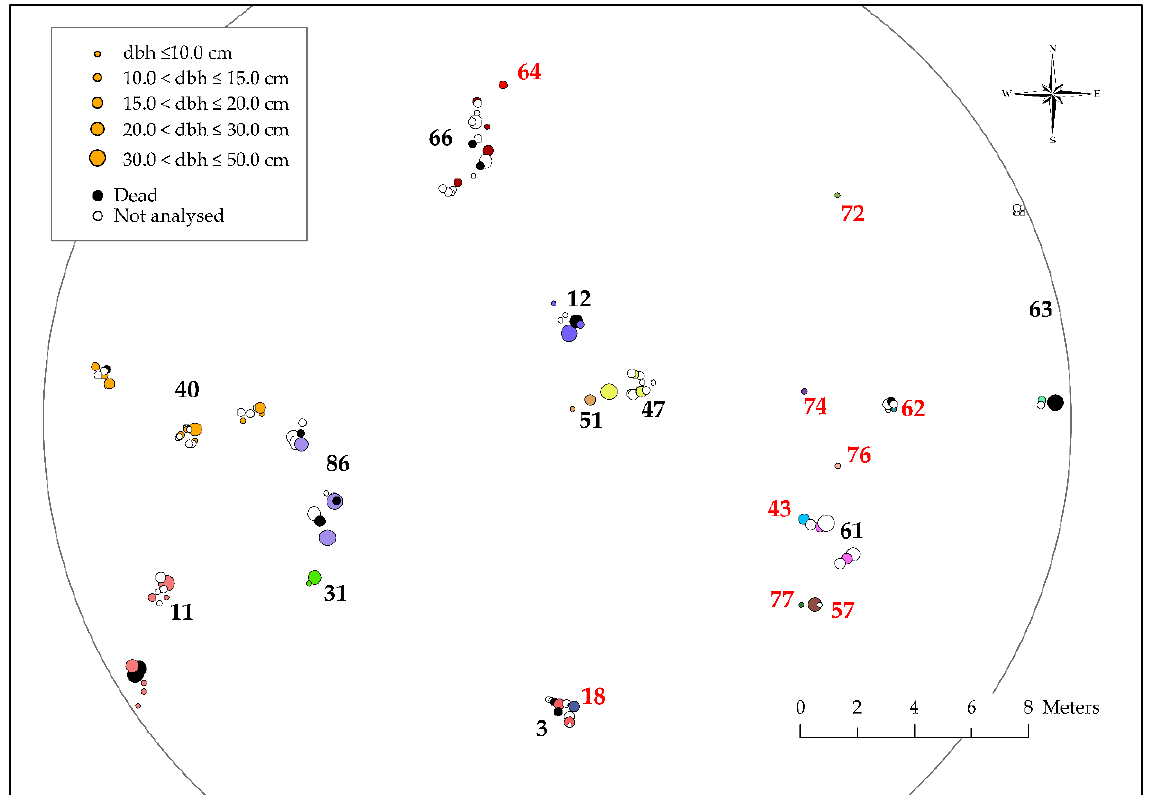
Figure 2. Clonal structure in plot A showing dead individuals (black), alive and not analyzed (white) and alive and analyzed (different colors for each MLG) and the dbh of each stem. Unique genotypes are numbered in red